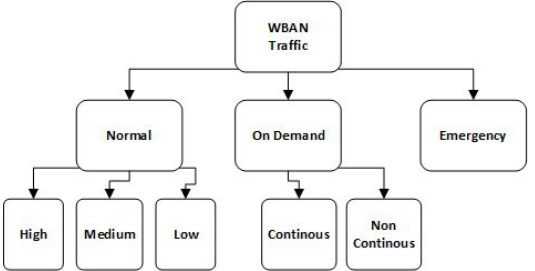
Figure 3. Traffic-adaptive priority-based MAC (TAP-MAC) traffic classification. WBAN: wireless body area